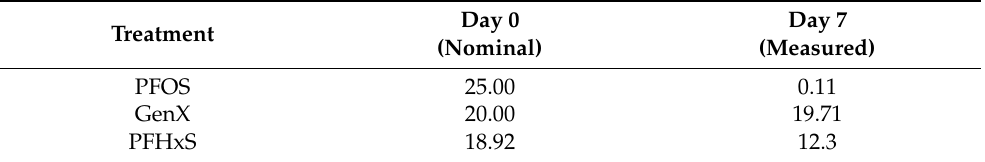
Table 5. Nominal and Measured PFAS concentrations ( µ g/L)in treatments (PFOS, GenX and PFHxS). Control water < 0.01 µ g/L of PFOS and PFHxS and < 0.1 µ g/L of GenX (limit of detection). Day 0 Treatment